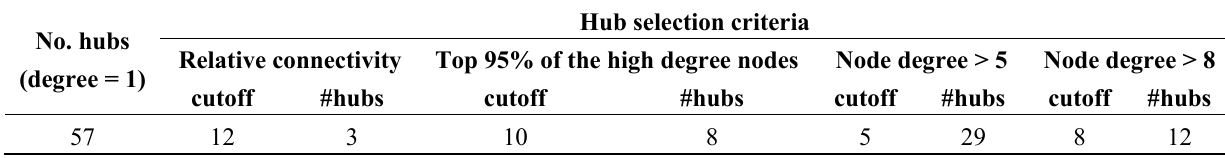
Table 4. No-hubs and hub selection criteria.